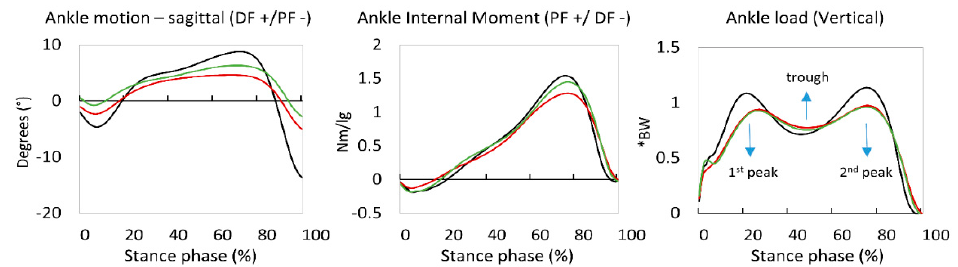
Figure 4. Waveform comparison of ankle motion (upper), ankle internal moment (middle), and ankle load (lower) of the control group (dot/dashed line), as well as and pre ‐ operative (dashed line) and post ‐ operative data (full line). Stance phase was time ‐ normalized to 100%. DF: dorsiflexion; PF: plantar flexion; BW: bodyweight; Nm: Newton meter.